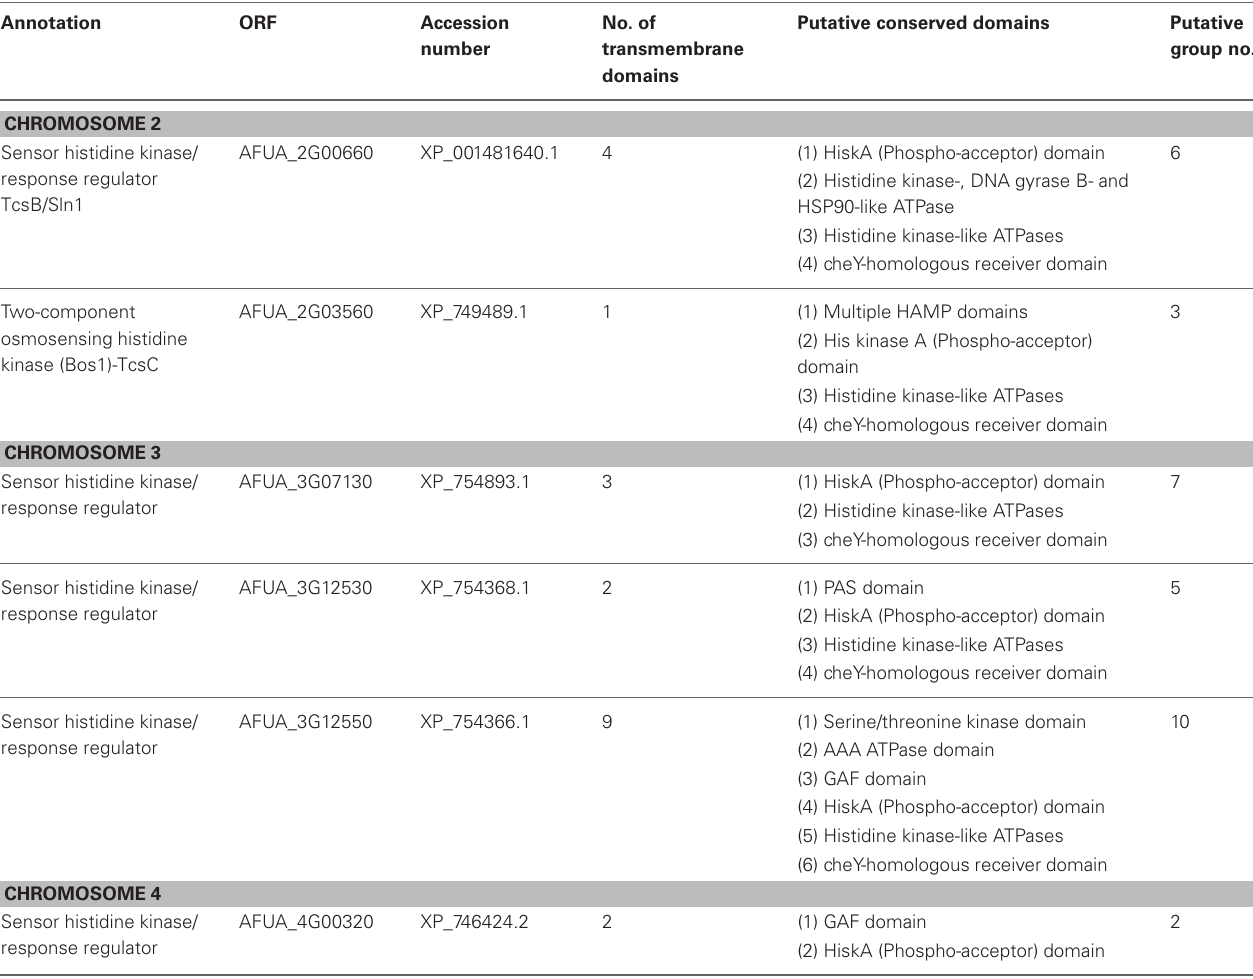
Table A2 | Identity and annotations of A. fumigatus histidine kinase